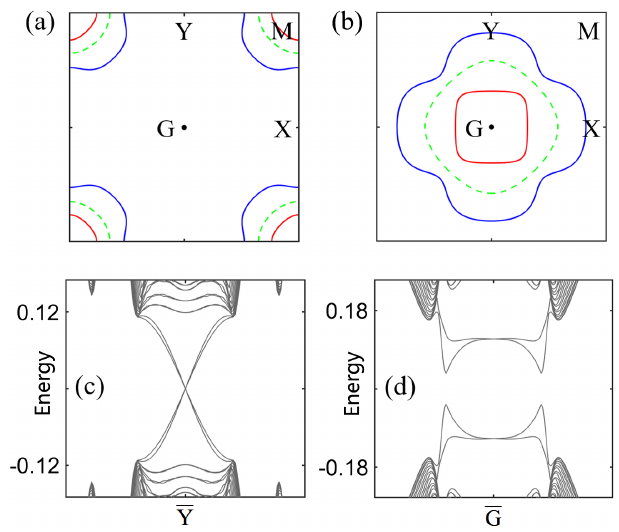
FIG. 3. (a) and (b) show the normal-state Fermi surfaces (solid lines) and the pairing nodes (dashed lines) for the Hamiltonian in Eq. (10). The red (blue) color in the figures means a positive (negative) superconducting pairing order on the Fermi surface. (c) and (d) show the edge modes on the (10) edge corresponding to the states depicted in (a) and (b), respectively. In (c) and (d), ¯ G are the projection points of Y and G on the edge, and respectively. The parameters are chosen as Δ 0 ¼ − 0 . 58 , Δ − 0 . 2 , and the chemical potential μ ¼ 3 . 6 for (a) and (c) 1 ¼ and Δ 0 ¼ − 0 . 3 , Δ 1 ¼ 0 . 2 , and μ ¼ 0 . 8 for (b) and (d). The other parameters are the same as those in Fig.